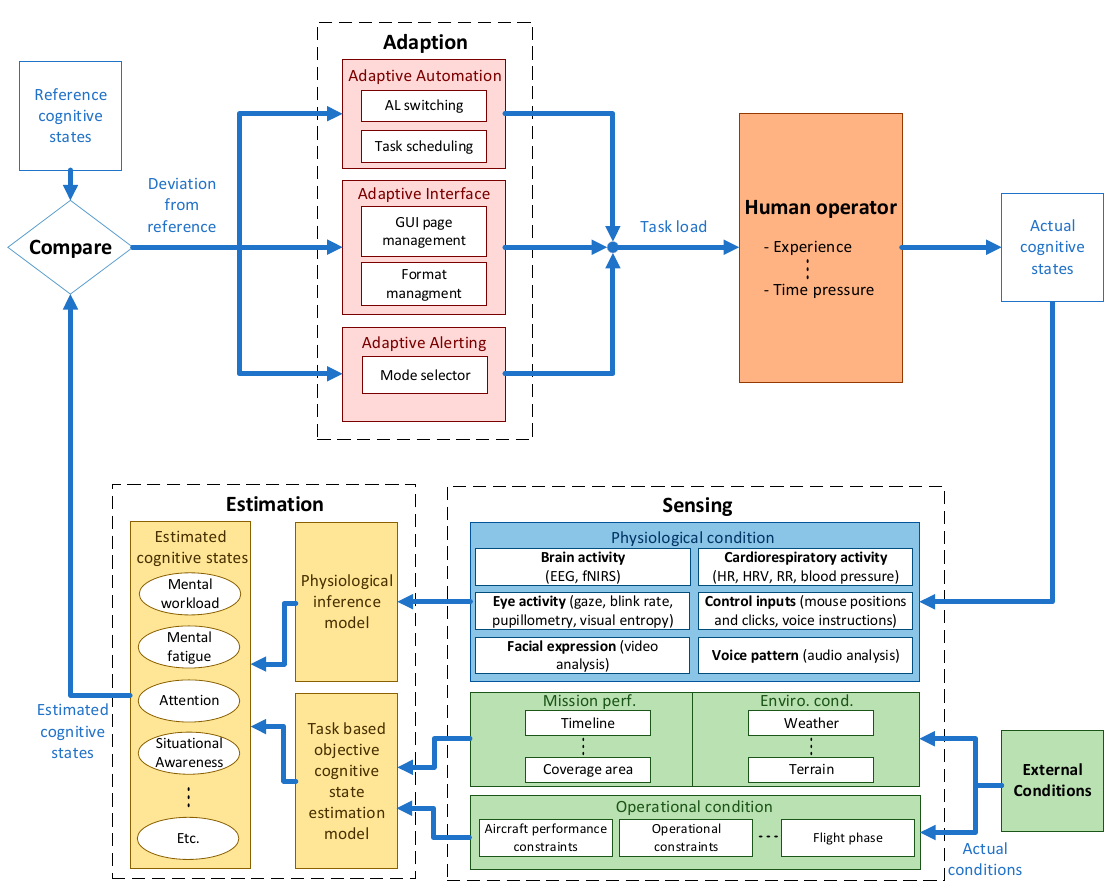
Figure 2. Cognitive Human Machine System (CHMS) framework.